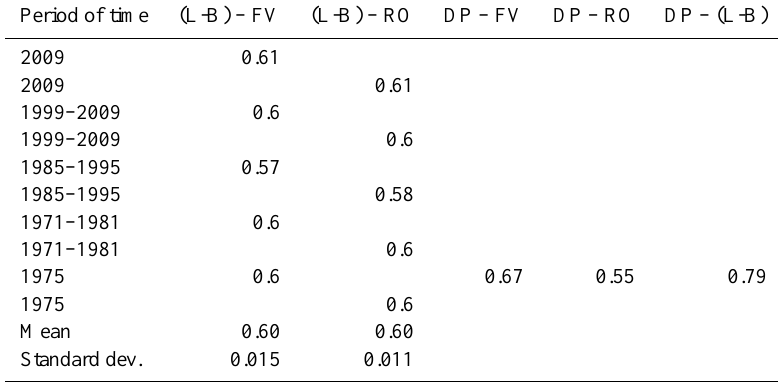
Table 3. Altitudinal temperature lapse rate on the western side of the Antarctic Peninsula ∗